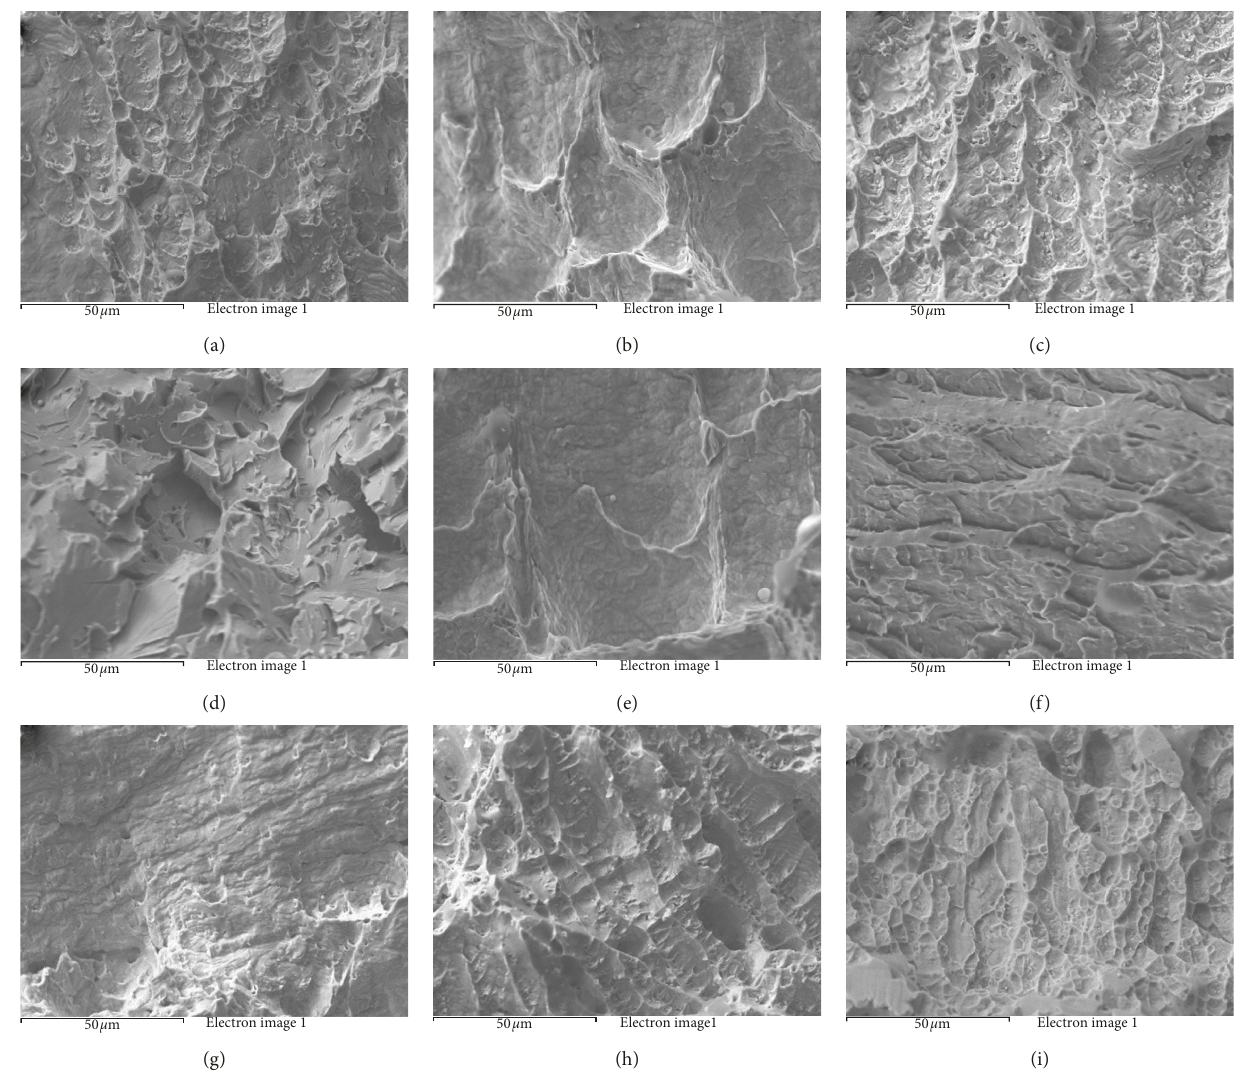
Figure 10: CTOD microfracture photo of the HAZ of L360QS/N08825 bimetallic composite pipe welded joint: (a), (b), (c) H1; (d), (e), (f) H2; (g), (h), and (i) H3.